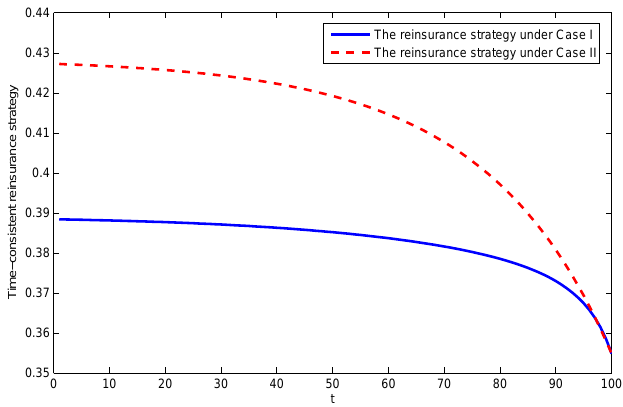
Figure 8. Time-consistent reinsurance strategy under the expected value principle ( α = 0.6 and T = 100).